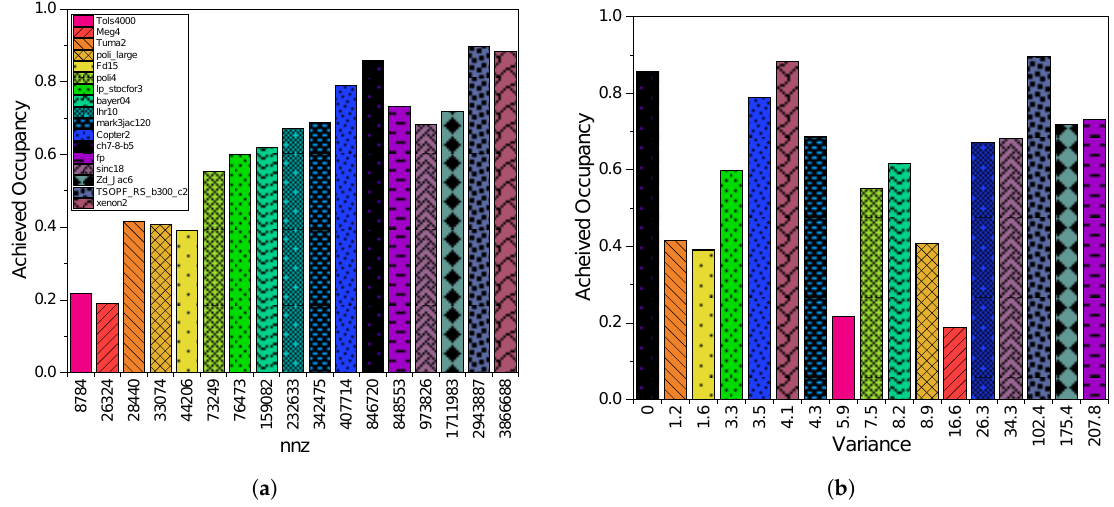
Figure 13. HYB achieved occupancy against: ( a ) nnz and ( b ) npr variance .